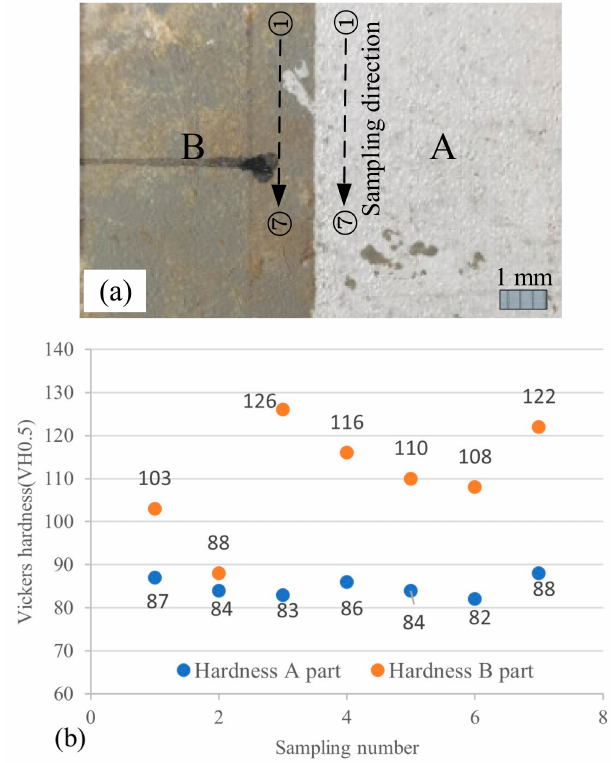
Figure 7. ( a ) Vickers hardness test sample; ( b ) Hardness test result.